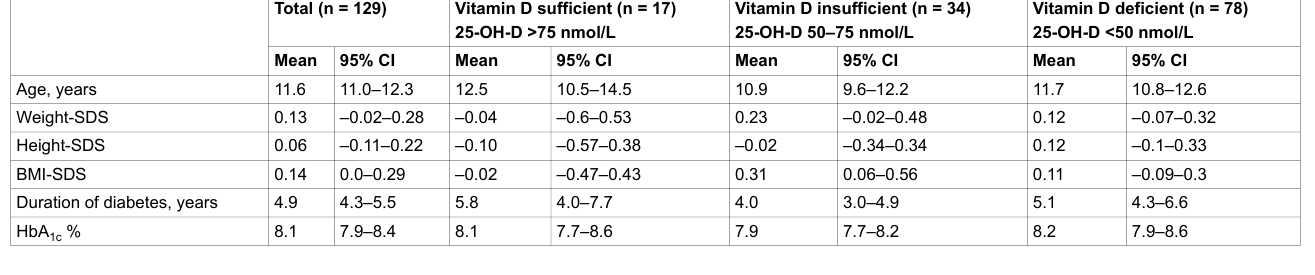
Table 1 Patient characteristics.